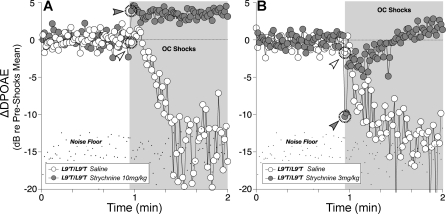
Strychnine Blocks OC Suppression in Mutant Ears(A) At 10 mg/kg, strychnine injection blocked OC-mediated DPOAE suppression in mutant mice, leaving only the slow OC-mediated enhancement seen in Chrna9 null mice [25].(B) At a lower strychnine dose (3 mg/kg), the onset of suppression in the mutant mice becomes more rapid, closely resembling the wild-type response without strychnine (Figure 7). Arrowheads in (A) and (B) indicate the first point after shock-train onset for each genotype: data acquisition times are approximately 1/point.